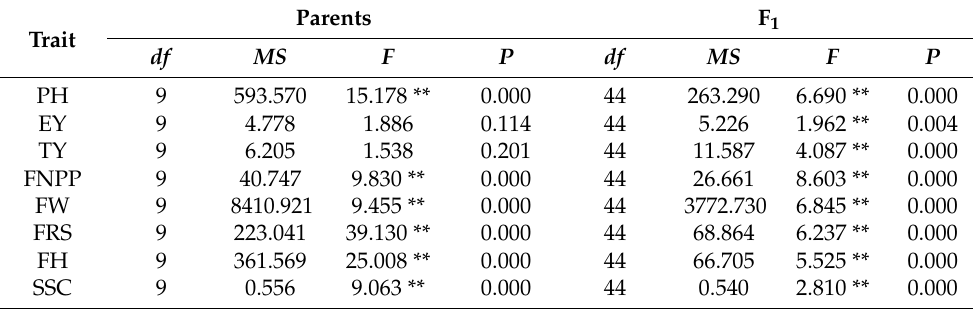
Table 3. Variance analysis of eight main agronomic traits in 10 parents and 45 F 1 hybrids.